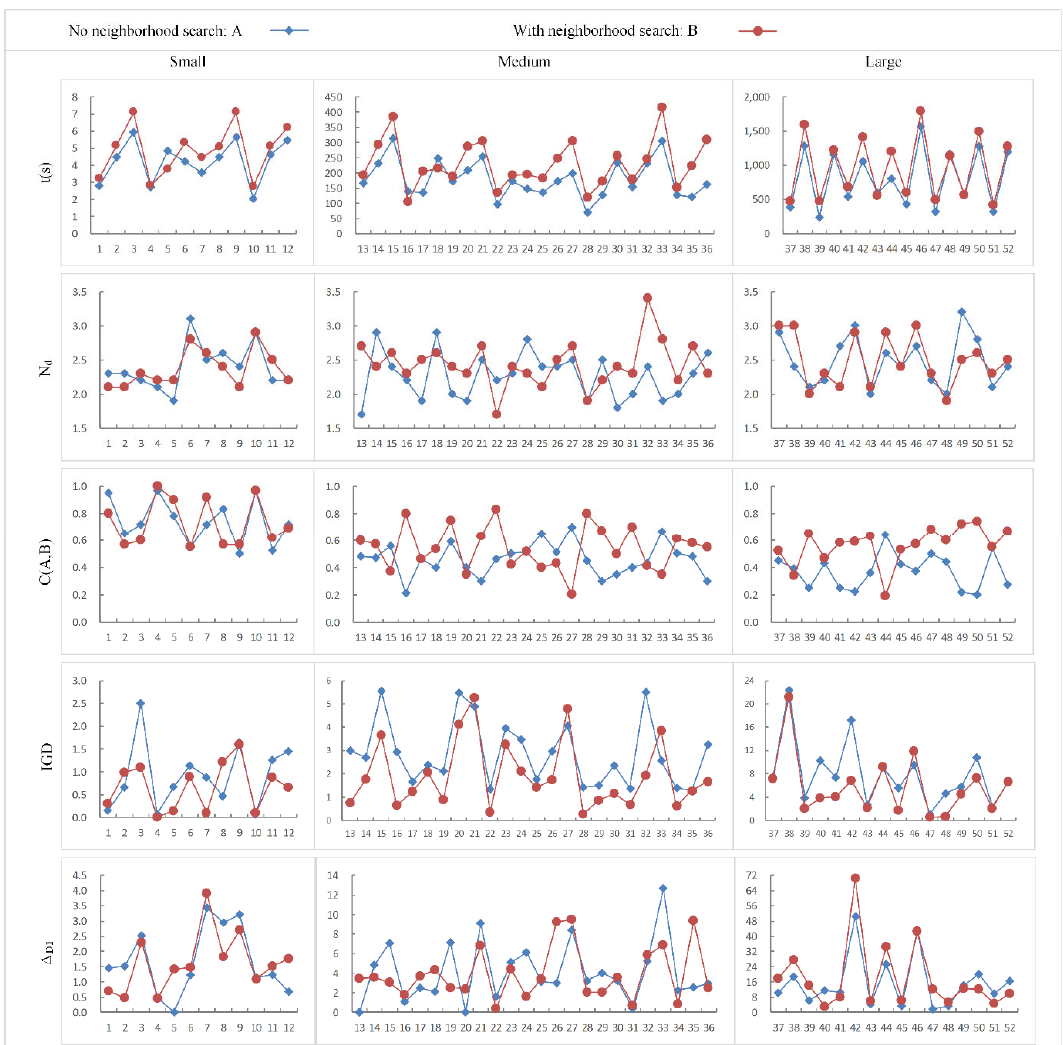
Fig. 6. Results for five performance metrics with and without neighbourhood search method